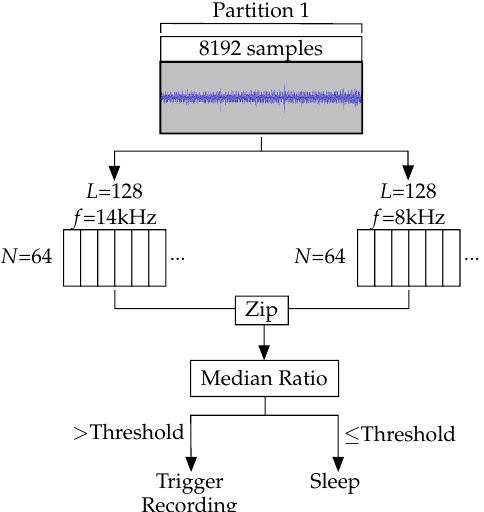
Figure 8. Overview of the sample collection and cicada detection process. Samples are collected in a single partition of the SRAM containing a maximum of 8192 samples. Once it is full, the samples are fed through two Goertzel filters in windows of 128 samples. The outputs from these filters are zipped together and the ratio of each pair is calculated. The median value of these ratios is compared to a threshold to decide either to record or return to sleep.